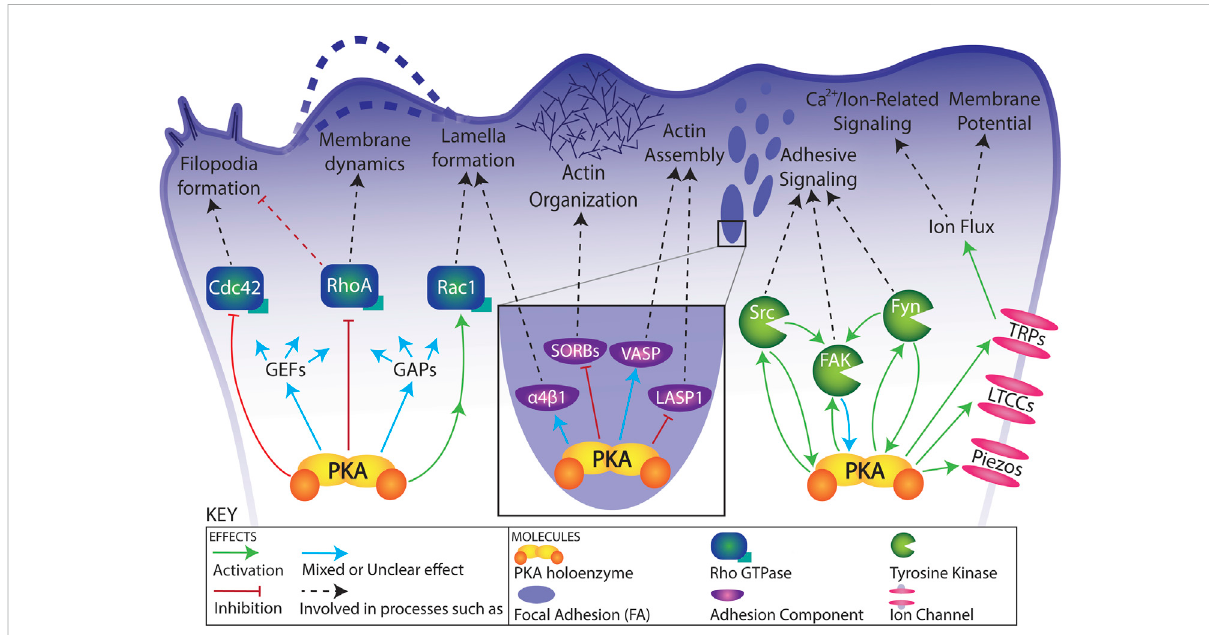
FIGURE 2 Schematic of functional connections between PKA and its targets in a migrating cell. Relationships are simpli fi ed for visual clarity. See text and Table 1 for details regarding functional